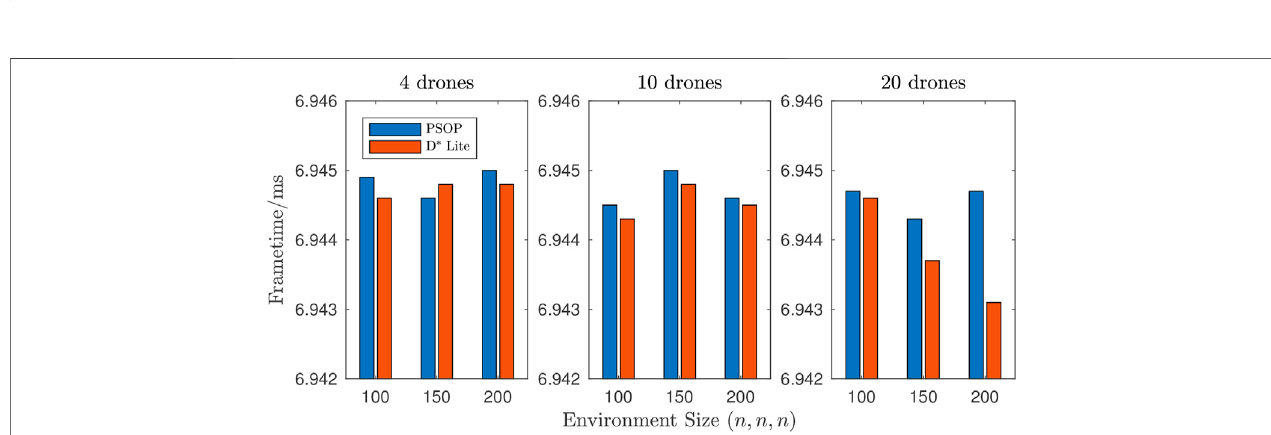
FIGURE 3 | Weighted mean frametime by environment size. The 4 drones case shows similar performance between the two algorithms when using D* Lite; whereas, there is a slight performance bene fi t when using PSOP for the 10 and 20 drone cases.